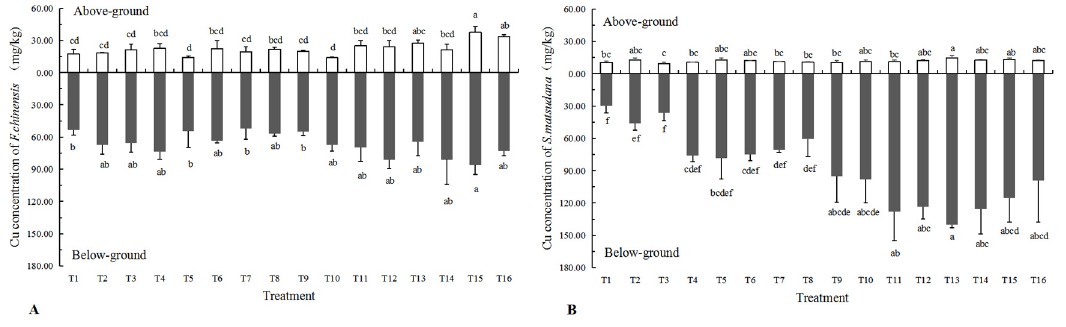
Figure 3. Cu concentrations of above-and below-ground parts of two woody species. ( A ) Cu concentration of F. chinensis ; ( B ) Cu concentration of S. matsudana × alba . Note: Values are mean ± SE. Different letters in a row indicate a significant difference, p < 0.05.